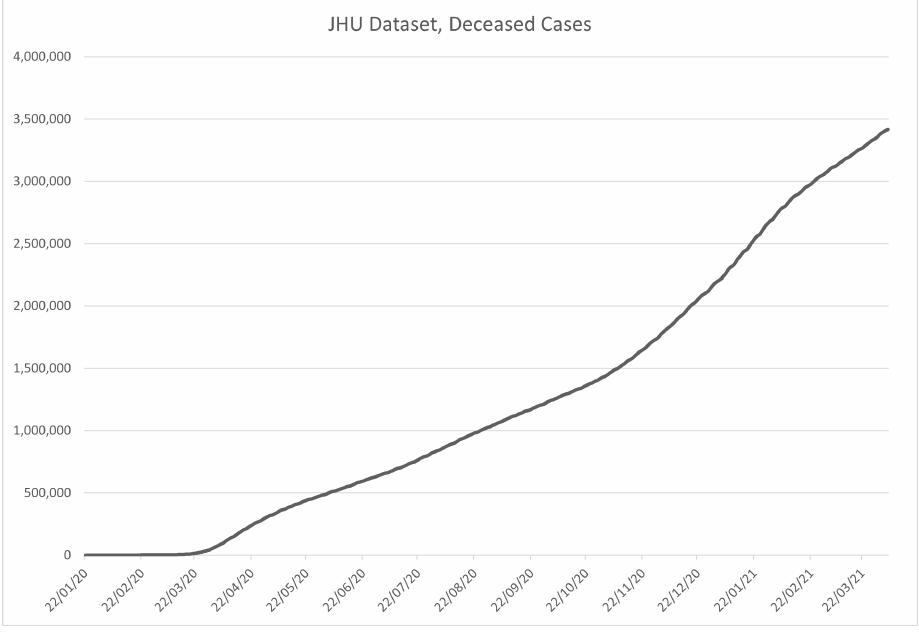
Figure 6. Time-series plot of the data in the JHU COVID-19 dataset, for deceased patients, contained within the